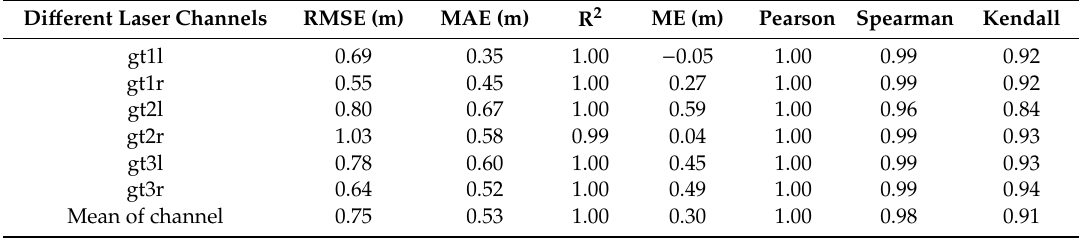
Table 4. The statistical indicators of the various laser channels.